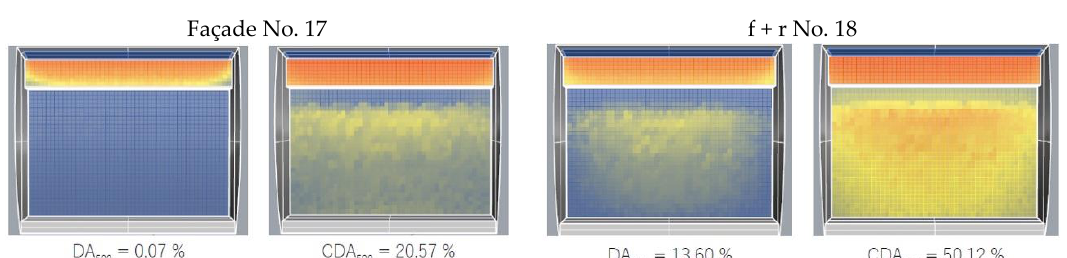
Figure A1. Occupancy profile.